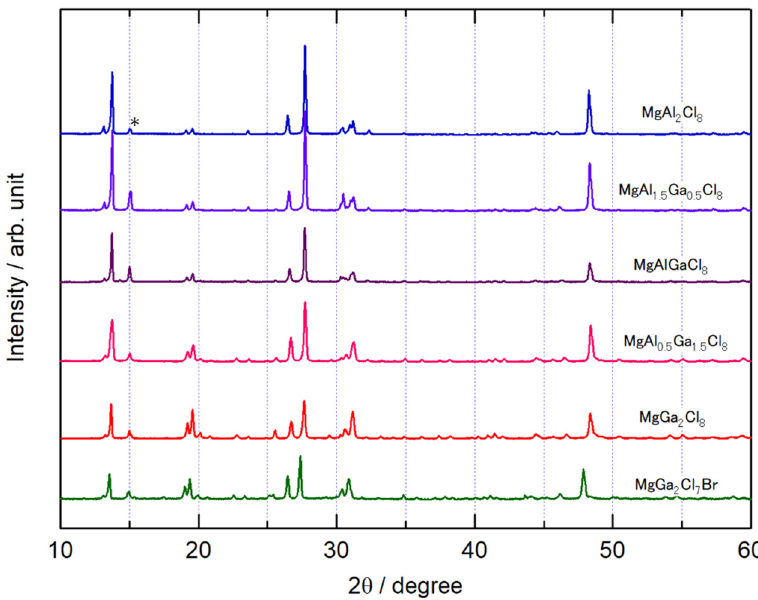
Figure 1. XRD patterns of MgAl 2-x Ga x Cl 8 and MgGa 2 Cl 7 Br. The MgCl 2 peak is indicated by Table 1. Results of the Rietveld analysis of XRD data for MgAl 2-x Ga x Cl 8.